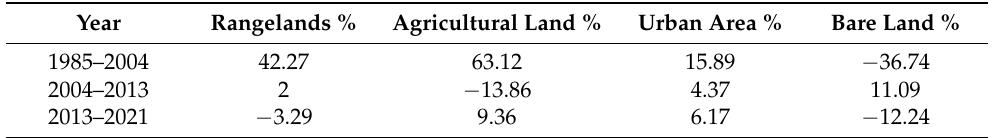
Table 5. Estimates of percentage change in land use in Irbid district computed over three time periods during 1985–2021.